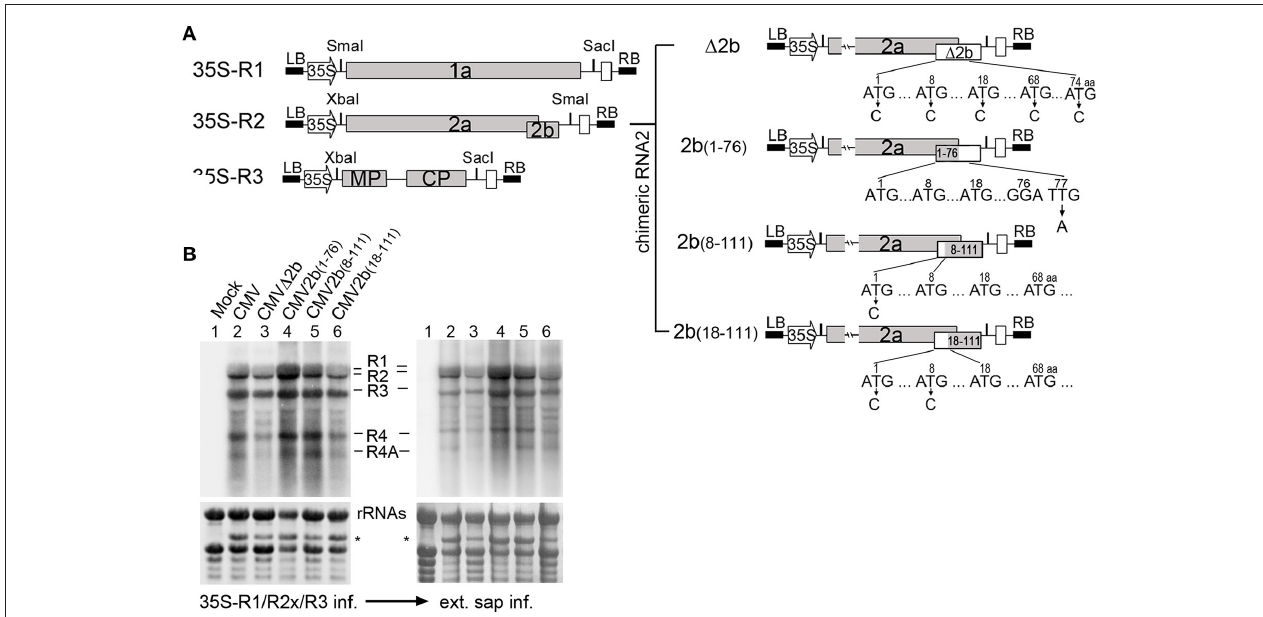
FIGURE 1 | Construction and biological activities of 2b mutants in the context of CMV infection. (A) Diagram of SD-CMV infectious clone construction. 35S-R1, 35S-R2, and 35S-R3 were the three full-length clones of SD-CMV genomic RNA1, RNA2, and RNA3 as well as four chimeric RNA2 mutants. R2a 1 2b, 2b protein expression was abolished; R2a2b (1 – 76) , with deletion of the C-terminal 35 amino acids; R2a2b (8 – 111) , with deletion of the N-terminal seven amino acids; and R2a2b (18 – 111) , with deletion of the N-terminal 17 amino acids. Substituting “C” for each “T” in the start codon ATG, as well as other ATG codons, or “A” for “T” in creating stop codon present in the 2b coding sequence are indicated with the numbers of the amino acid positions. (B) RNA gel blot detection of CMV accumulation in Agrobacterium -inoculated leaves (left panel) and the plants inoculated with sap extracted from each CMV2b (x) -infected Nb leaf (right panel). SD-CMV genomic RNA 3 ′ UTR was used as a probe. Methylene blue-stained ribosomal rRNA was used as loading control. *A stained viral RNA used as an indicator of SD-CMV